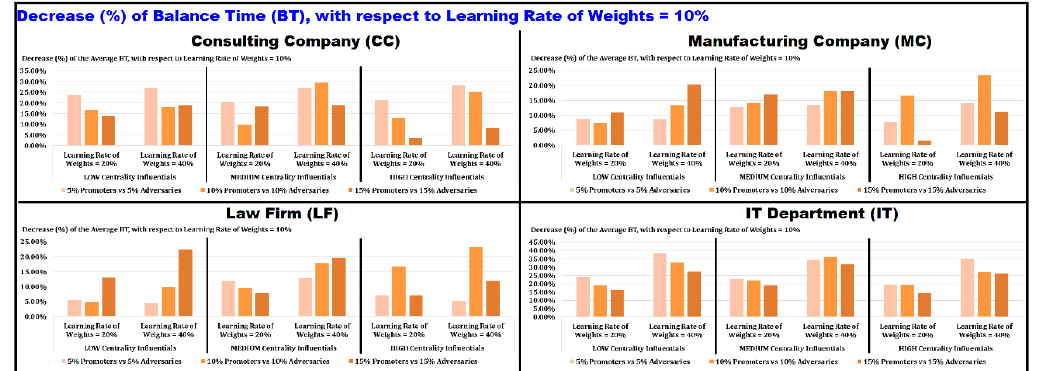
the decrease when promoters and adversaries increase from 5% to 15%.